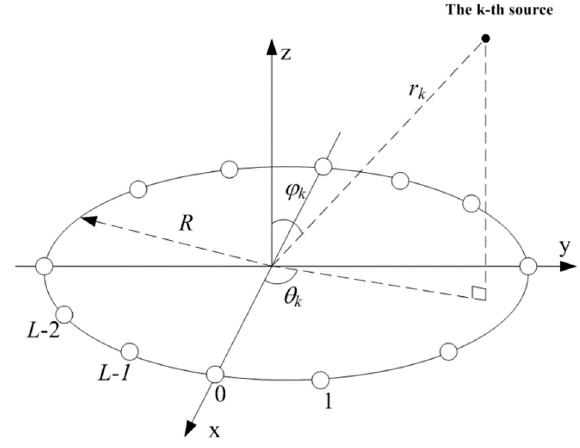
Figure 1. The uniform circular array configuration.